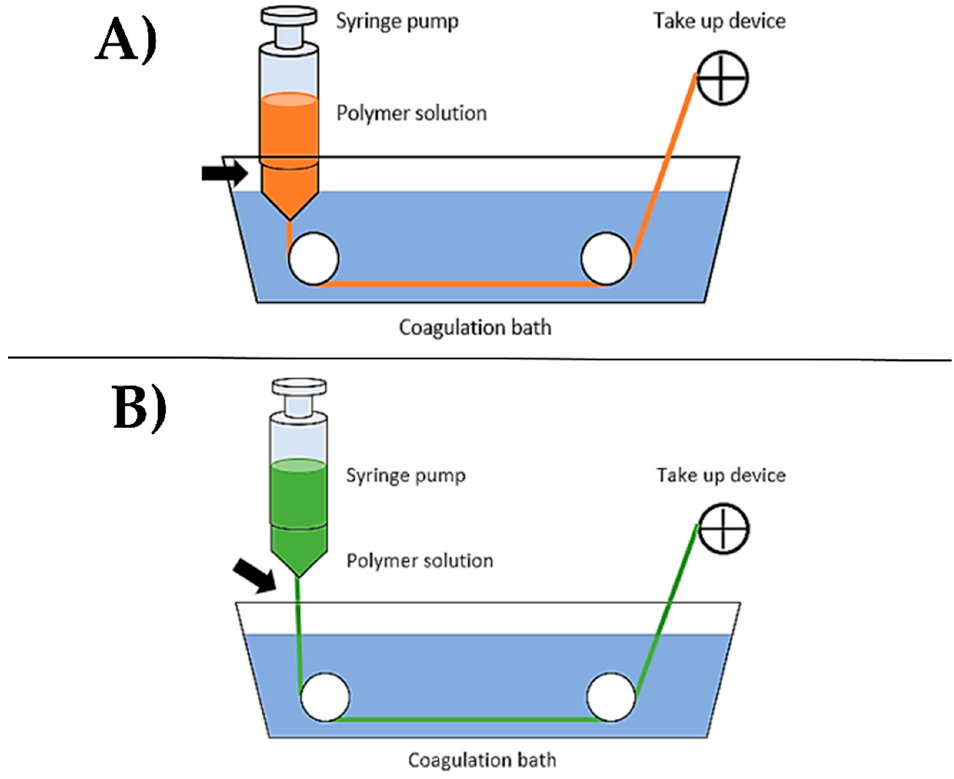
Figure 4. Common systems of ( A ) wet spinning, and ( B ) dry-jet wet spinning. In dry-jet wet spinning, the polymer solution is extruded through an air gap before the coagulation bath, resulting in higher molecular alignment compared to conventional wet spinning [124,141,142].